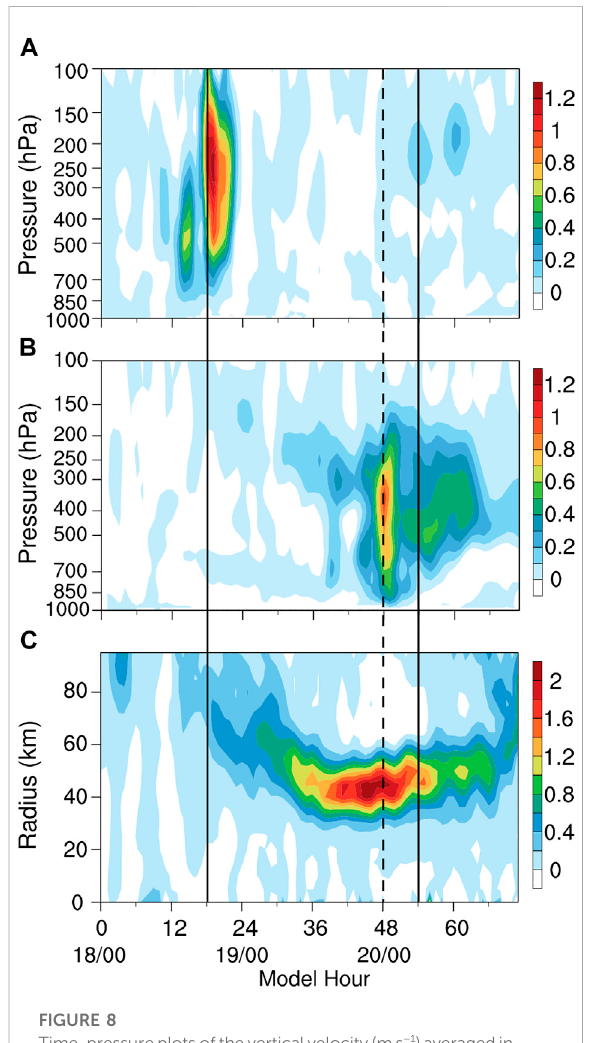
FIGURE 8 Time-pressureplotsoftheverticalvelocity(ms − 1 )averagedin theannuluswitharadiusof400 – 500 km (A) southand (B) northof the TC center, and (C) the time-radius plot of the azimuthally averaged vertical velocity (m s − 1 ) at 500 hPa. The reference lines represent the same meaning as those in Figure 6.